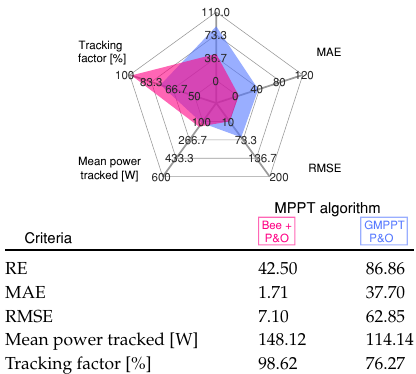
Figure 18. Comparative analysis of the MPPT methods for Scenario 6 shown in Figure